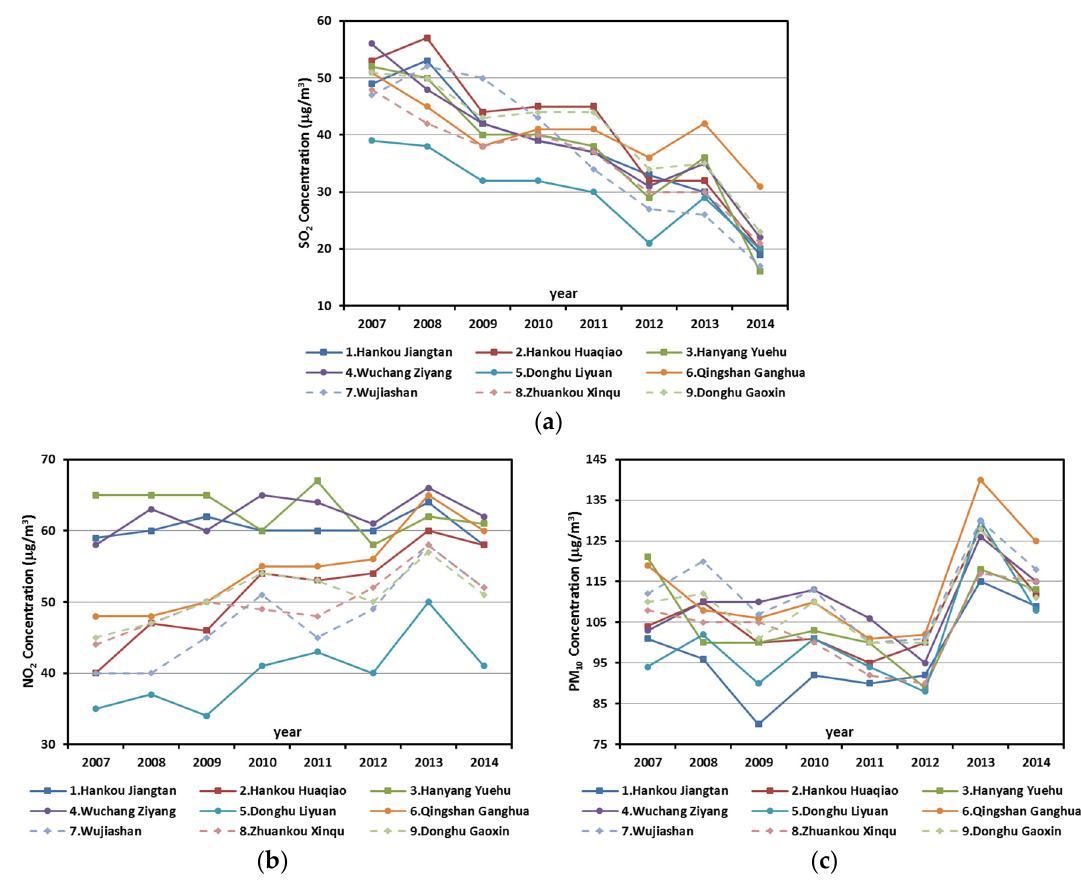
Figure 3. Inter-annual variation of air pollutants distinguishing nine sites from 2007 to 2014. ( a ) SO 2 ; ( b ) NO 2 ; ( c ) PM 10 .